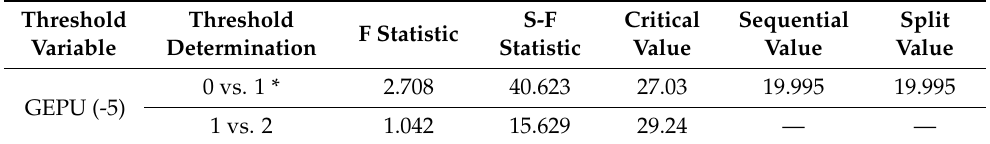
Table 4. Corn price threshold quantity determination